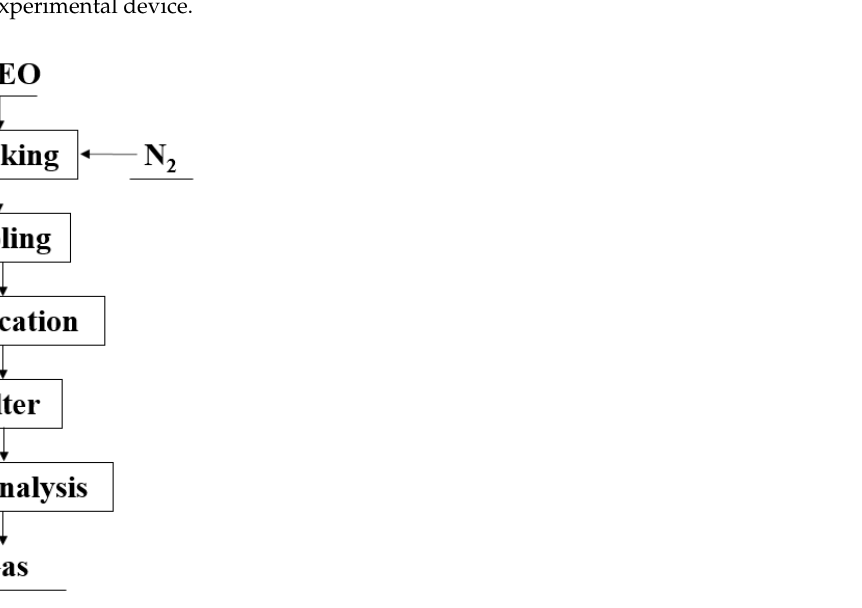
Figure 2. Working flow chart.